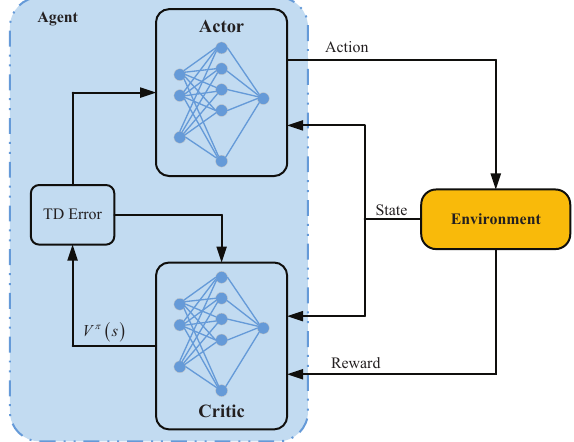
Figure 5. The structure of deep actor-critic reinforcement